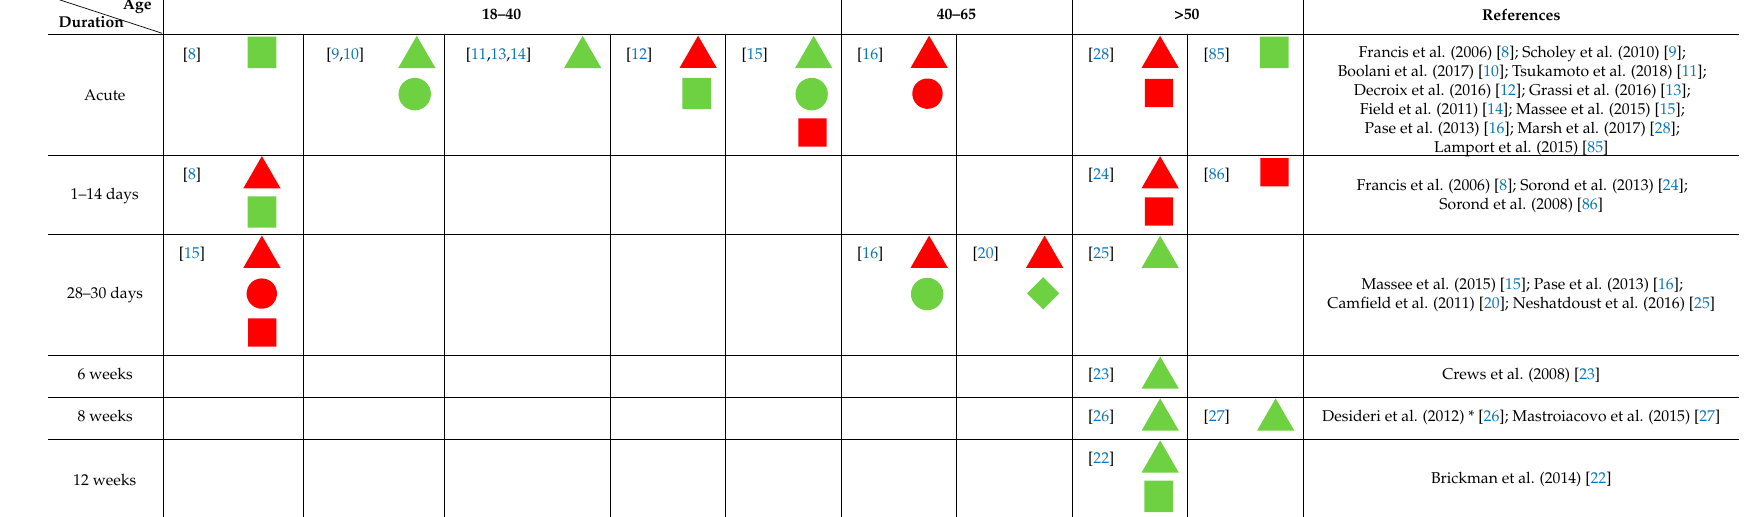
Table 2. Randomised controlled trials assessing the effects of cocoa on brain function.